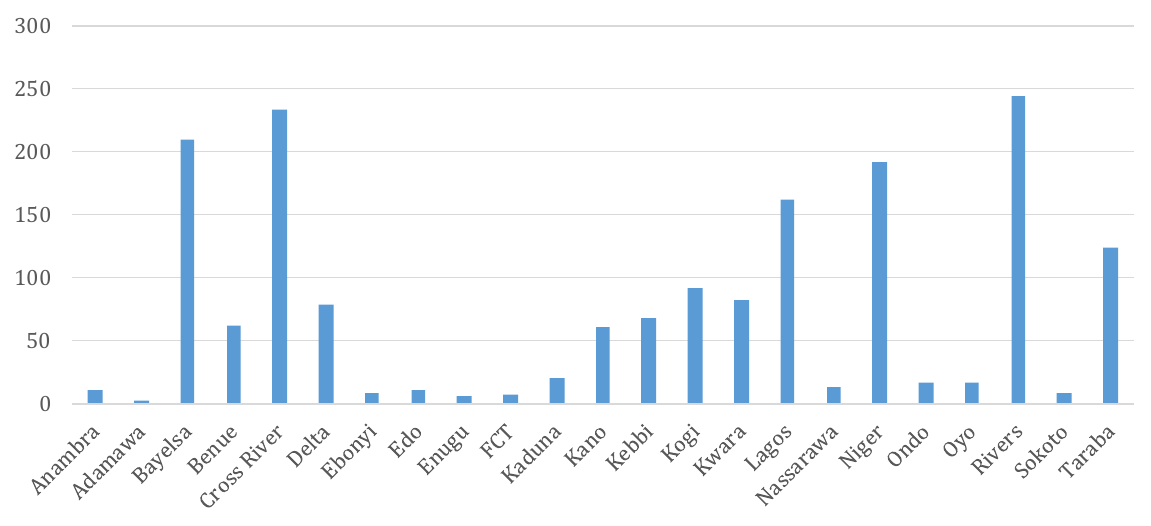
Figure 5: Boat instability accidents in Nigerian states